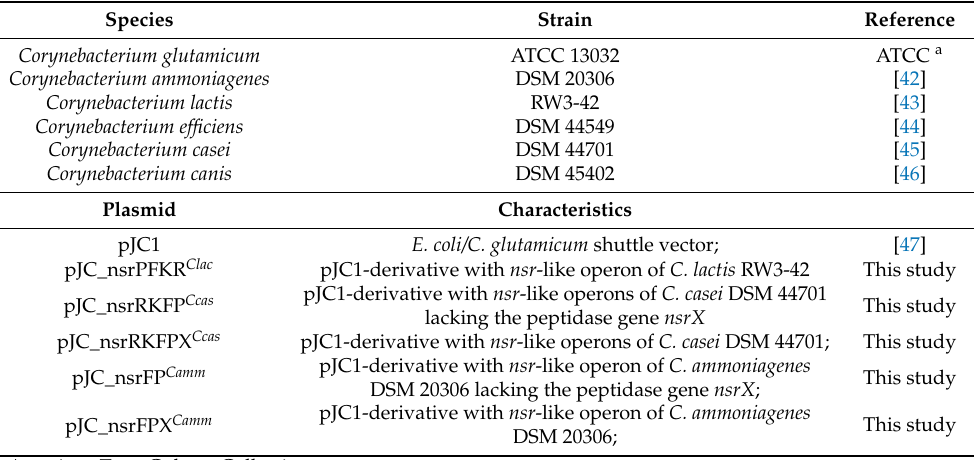
Table 1. Bacterial strains and plasmids used in this